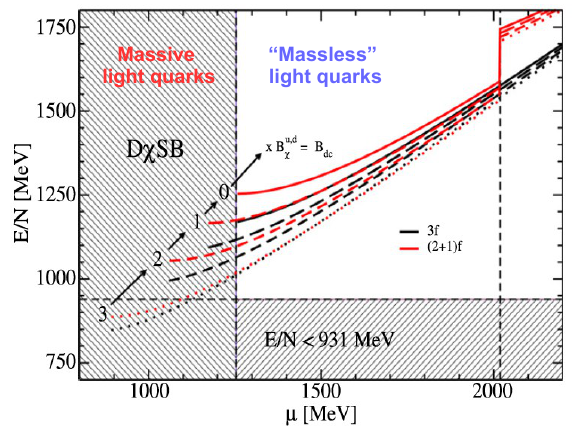
Figure 1. Energy per baryon vs. baryon chemical potential for the vBag quark matter model [36]. Absolutely stable strange quark matter could be obtained if dynamical chiral symmetry breaking (D χ SB) is neglected. However: The vertical band marks the approximate region where chiral symmetry is broken. For the shown curves D χ SB is ignored for all (black) or all but the s-quark (red). At densities below the s-quark threshold this allows to e ff ectively compare two(red)- and three-flavor(black) quark matter for di ff erent e ff ective bag constants. In none of the cases strange matter is more stable than iron (E / N < 931 MeV) in a density domain where chiral symmetry is